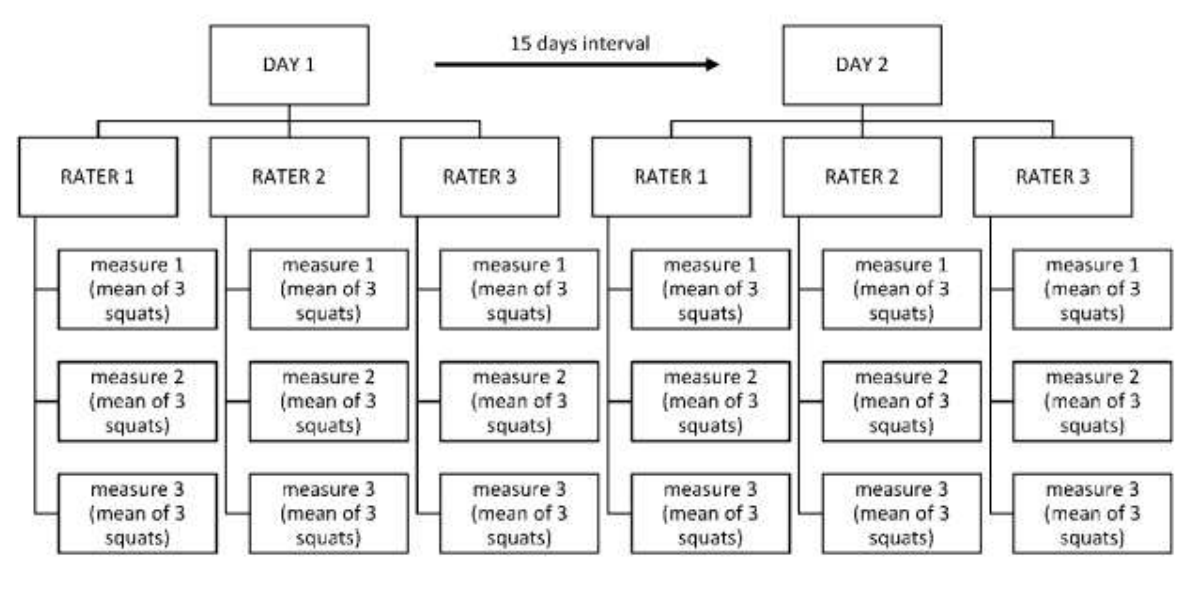
Diagram Illustrating the Measurement